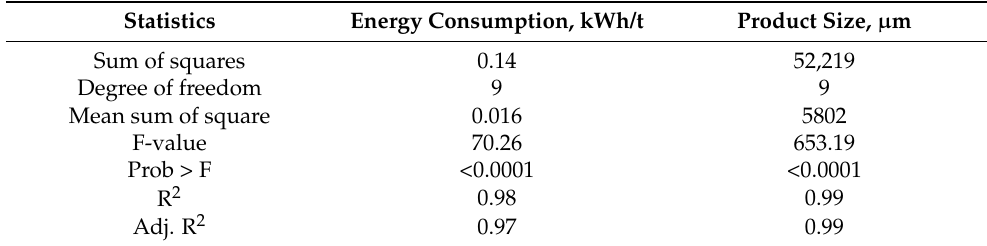
Table 3. Analysis of variance for the energy consumption and product